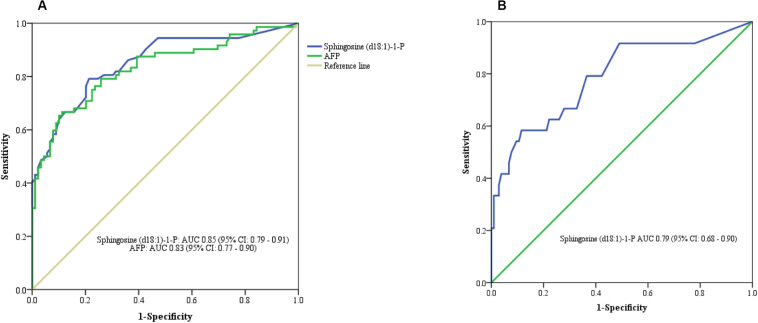
ROC curve analysis. (A) Serum Sphingosine (d18:1)-1-P for differentiating HCC from cirrhotic patients. (B) Serum Sphingosine (d18:1)-1-P for differentiating APF-negative HCC from cirrhotic patients.